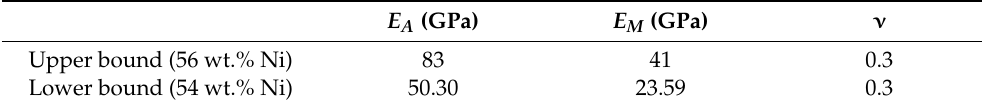
Table 3. Upper/lower bound values of stiffness with respect to Ni content in NiTi used in RVEs. E A (GPa) E M (GPa) ν Upper bound (56 wt.% Ni)